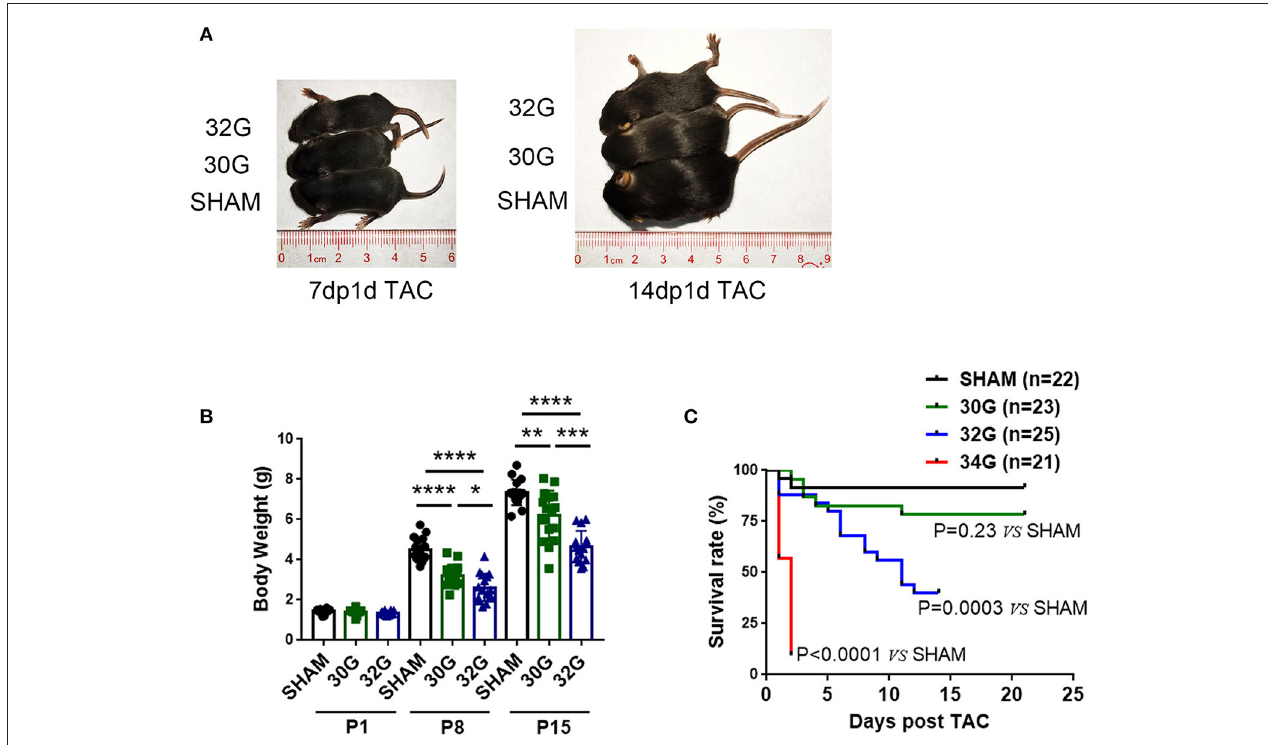
FIGURE 1 | Effect of different degrees of pressure overload on the growth of neonatal mice. (A,B) Both 30-gauge (30G) and 32-gauge (32G) TAC affected the growth and development of mice; Representative images of 32G TAC mice (up), 30G TAC mice (middle) and sham mice (down); 7dp1d TAC: 7 days post 1 day TAC;